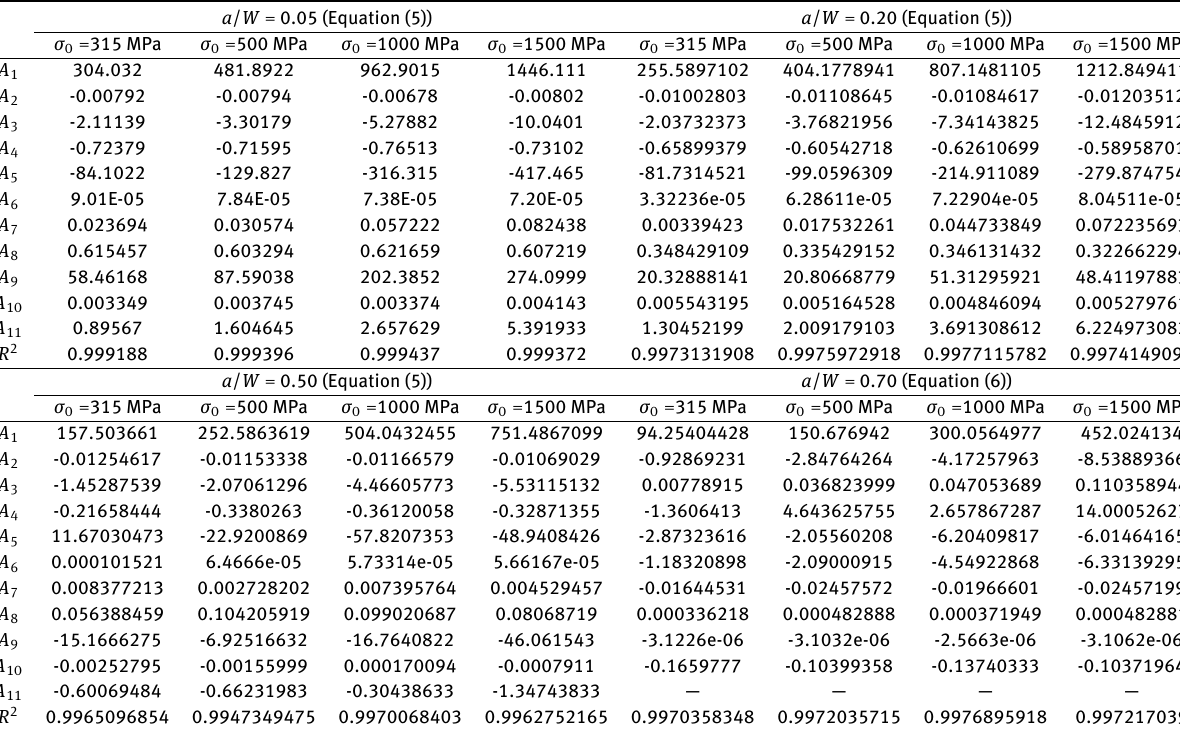
Table 9: Approximation coefficients for Eqs. (5) and (6) required to calculate the limit load ( σ 22 ) P 0 for CCSP(BT) – 3D